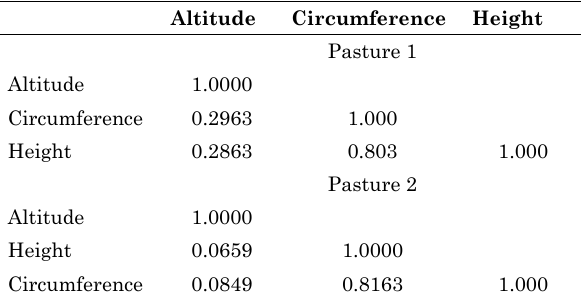
Table 3. Matrix of correlation between sizes of epigeous termite mounds